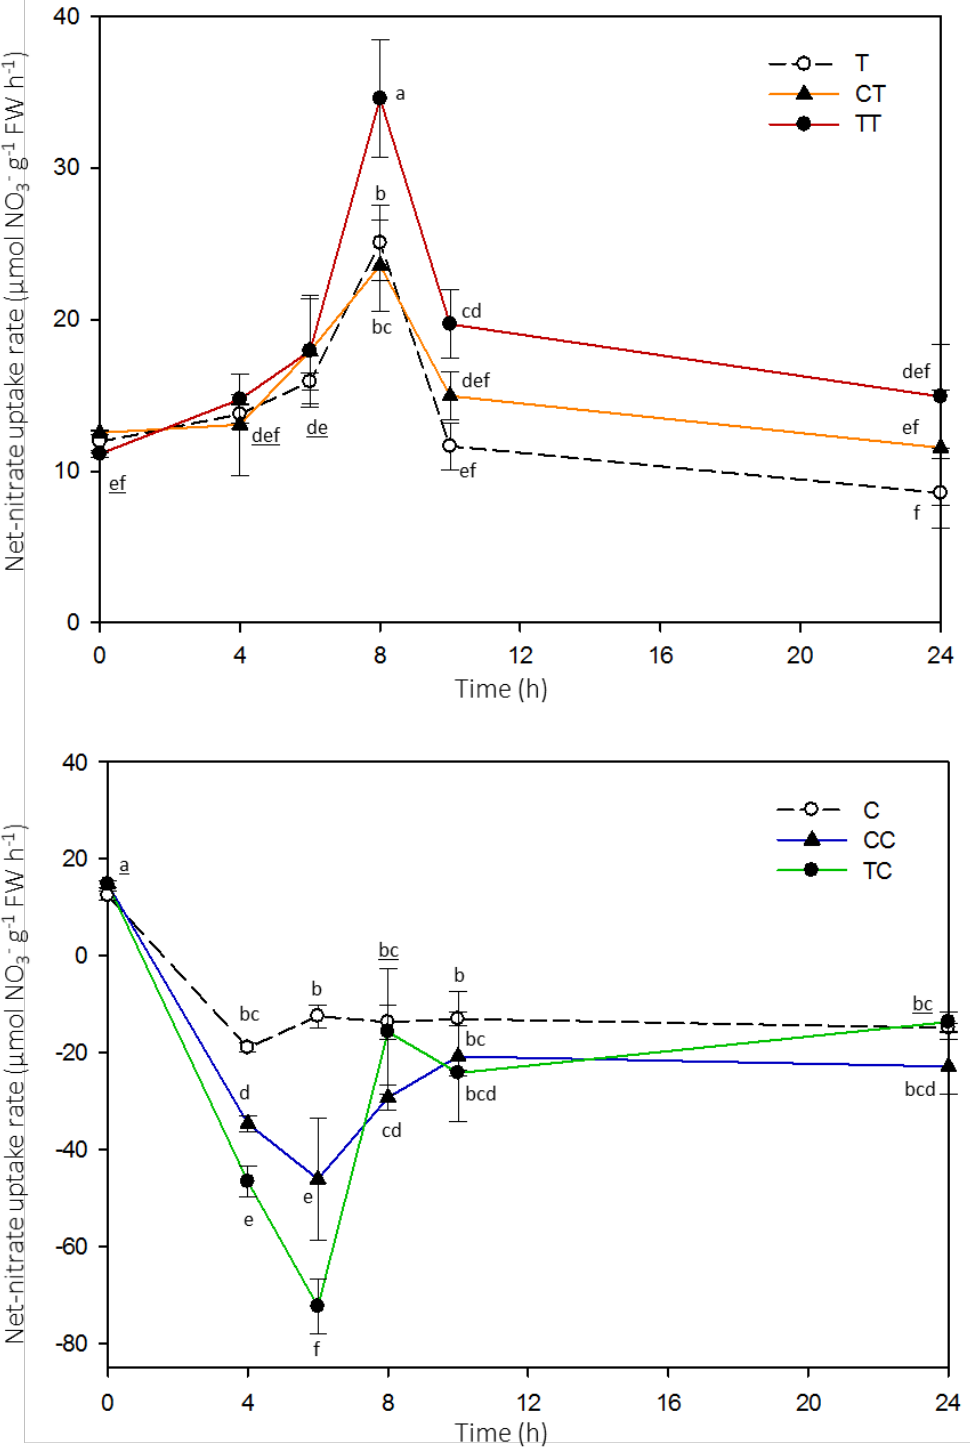
Figure 2. Time-course of high-affinity net-nitrate uptake rate in Arabidopsis roots. During the time span of the experiment (24 h), Arabidopsis plants were exposed to a nutrient solution containing 1 mM nitrate. After 0, 4, 6, 8, 10 or 24 h, groups of six plants from each treatment were transferred into the assay solution (0.5 mM CaSO 4 containing 100 µ M nitrate, up to 10 min). The values are means ± SD, small letters refer to statistical significance; underlined letters refer to statistical significance of two overlapping points (one-way ANOVA, Student-Newman-Keuls method, N = 3, p -value < 0.05). FW, fresh